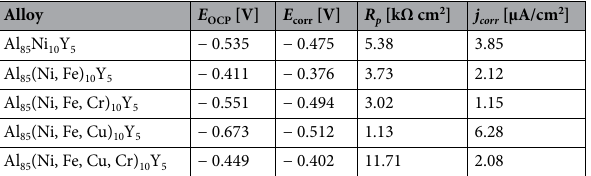
Table 1. Results of polarization tests of Al 85 TMs 10 Y 5 alloys in 3.5% NaCl solution at 25